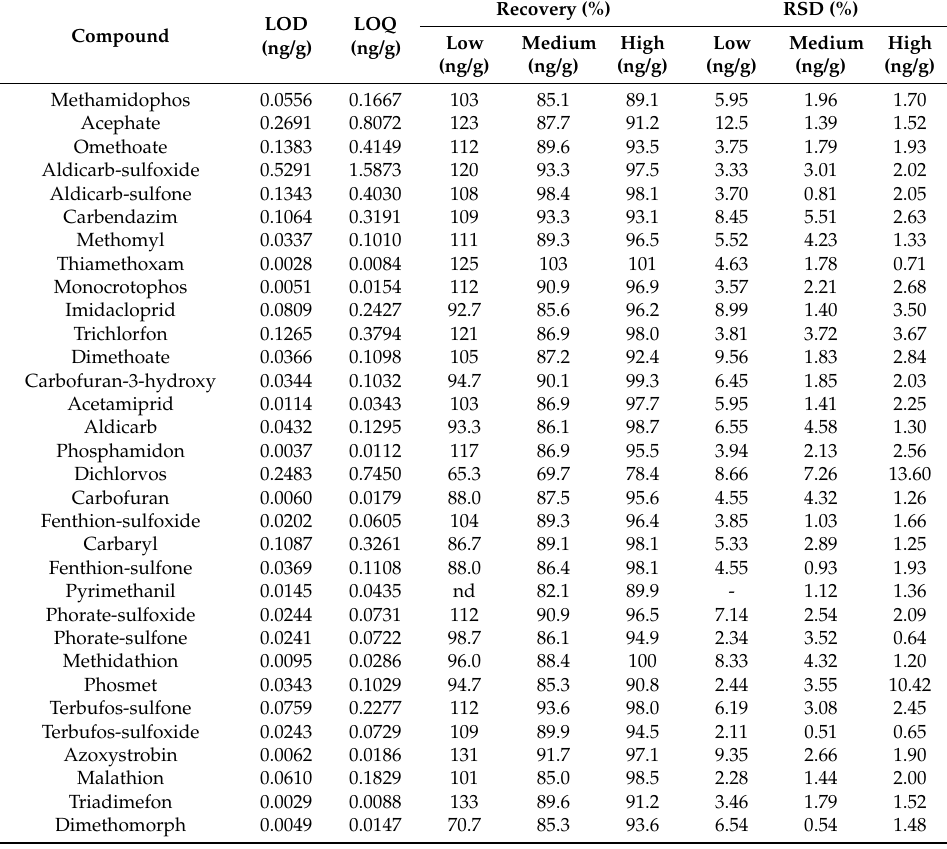
Table 3. Limit of determination and quantification (LOD and LOQ) of the method, recovery of analytes, and repeatability (relative standard deviations, RSD) obtained in